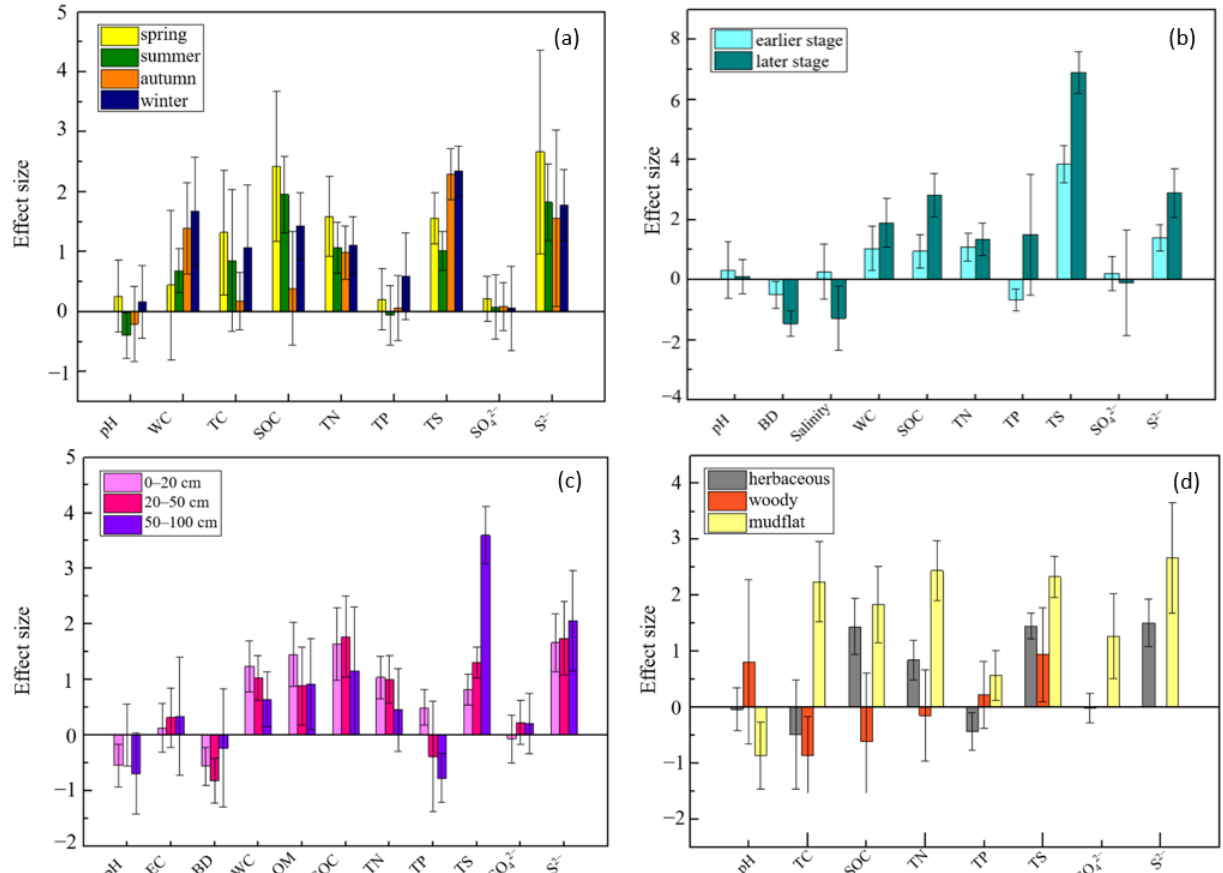
Figure 5. Effects of S. alterniflora invasion on soil properties in different subgroups. The y-axis is the SMD of soil properties in invaded vs. native areas, grouped by ( a ) seasons, ( b ) invading stages, ( c ) depths, and ( d ) life forms of native species. The parallel line was at SMD = 0. EC, electrical conductivity; TC, total carbon; SOC, soil organic carbon; OM, organic matter; TN, total nitrogen; TP, total phosphorus; TS, total sulfur.